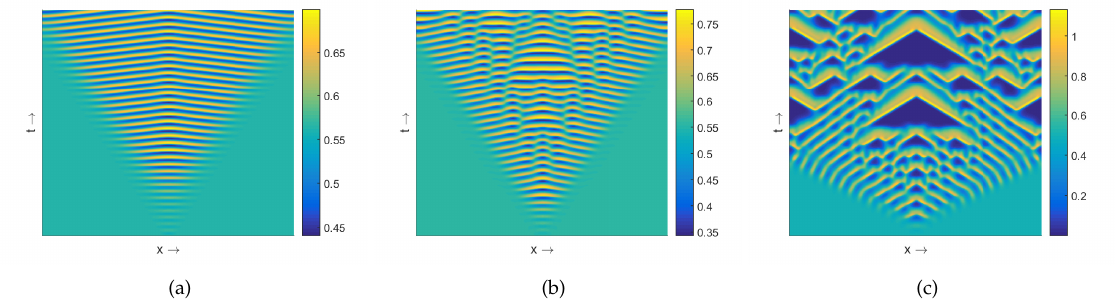
Figure 5. Bifurcation diagram in ( M , β ) -parameter space for fixed parameters a = 1, b = 1, σ 1 = 0.1, α = 0.4, κ = 0.4 and σ 2 = 0.2. ( a ) d 1 = 1, d 2 = 1; ( b ) d 1 = 0.7, d 2 = 0.5.